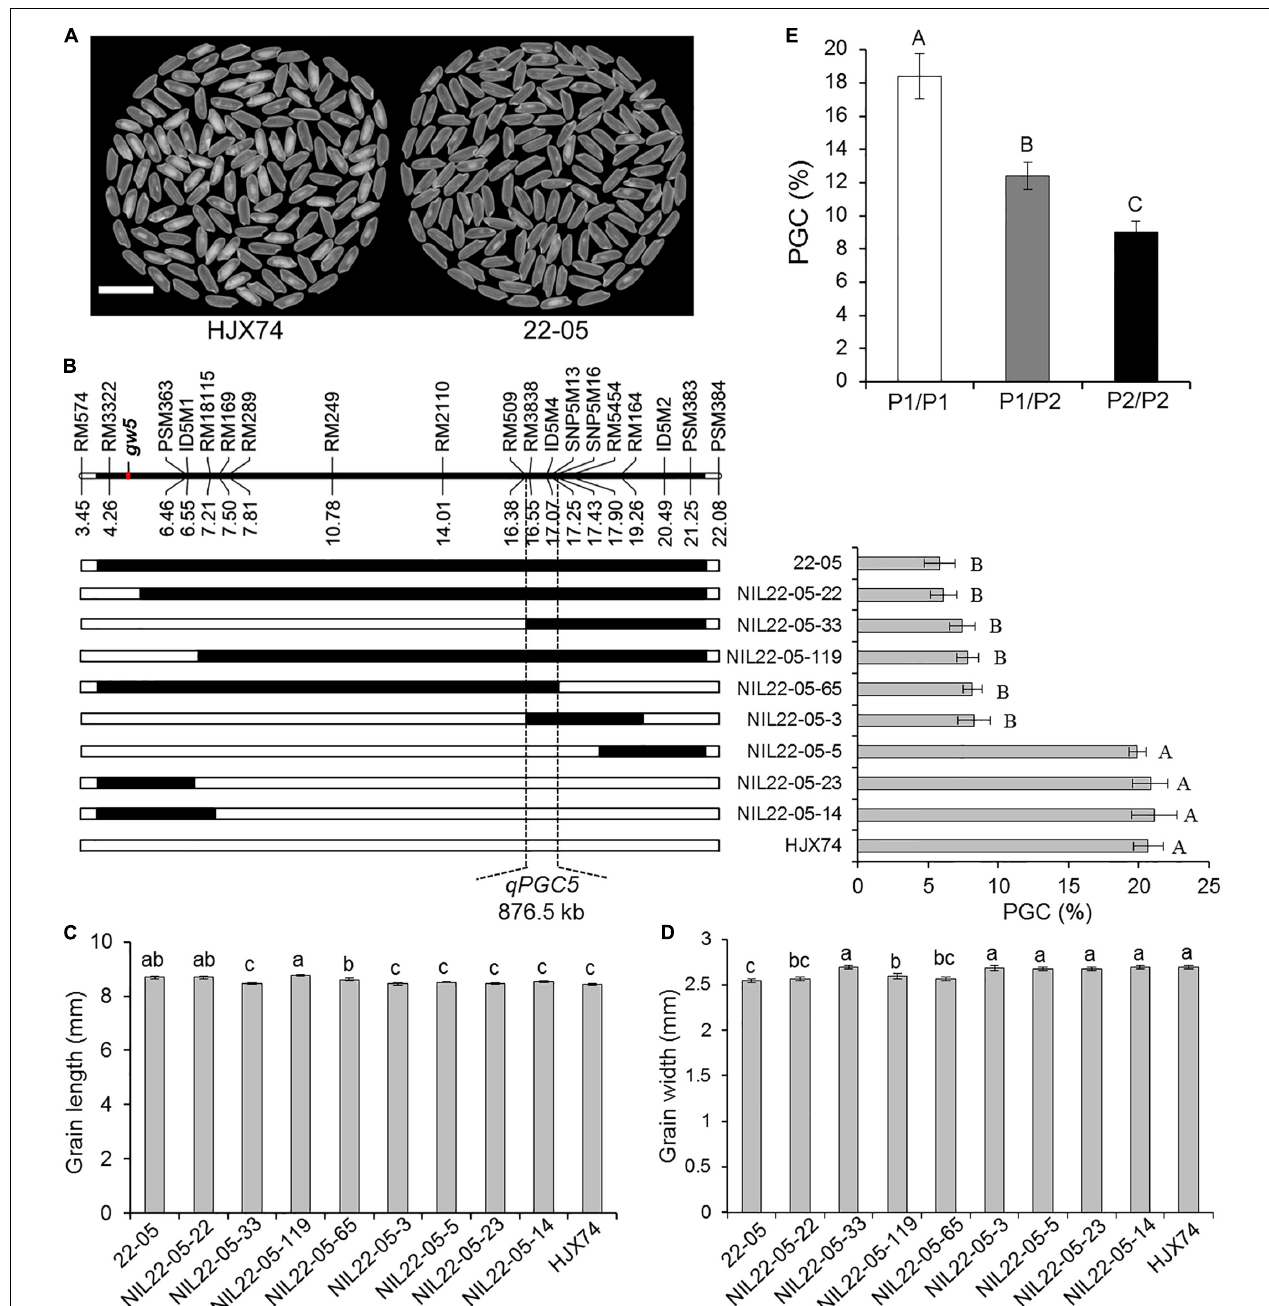
FIGURE 2 | Substitution mapping of qPGC5. (A) The appearance of milled rice of SSSL 22–05 and control HJX74. Scale bar, 1 cm. (B) Substitution mapping of qPGC5 in SSSL 22–05. The positions of markers on the chromosome are shown in physical distance (Mb). The position of gw5 gene is shown on the chromosome. Black blocks show the substitution segments from 22–05 in NILs. PGC (%) is the mean ± S.E. of two cropping seasons. Grain length (C) and width (D) of 22–05 and NILs are given as the mean ± S.E. of two cropping seasons. (E) PGC of three qPGC5 genotypes in an F 2 population. P1/P1, The genotype of qPGC5-HJX74/qPGC5-HJX74 ( n = 25); P1/P2, The genotype of qPGC5-HJX74/qPGC5-NIL ( n = 48); P2/P2, The genotype of qPGC5-NIL/qPGC5-NIL ( n = 27). Different uppercase letters and lowercase letters indicate significant differences at the 0.05 level and 0.01 level, respectively.